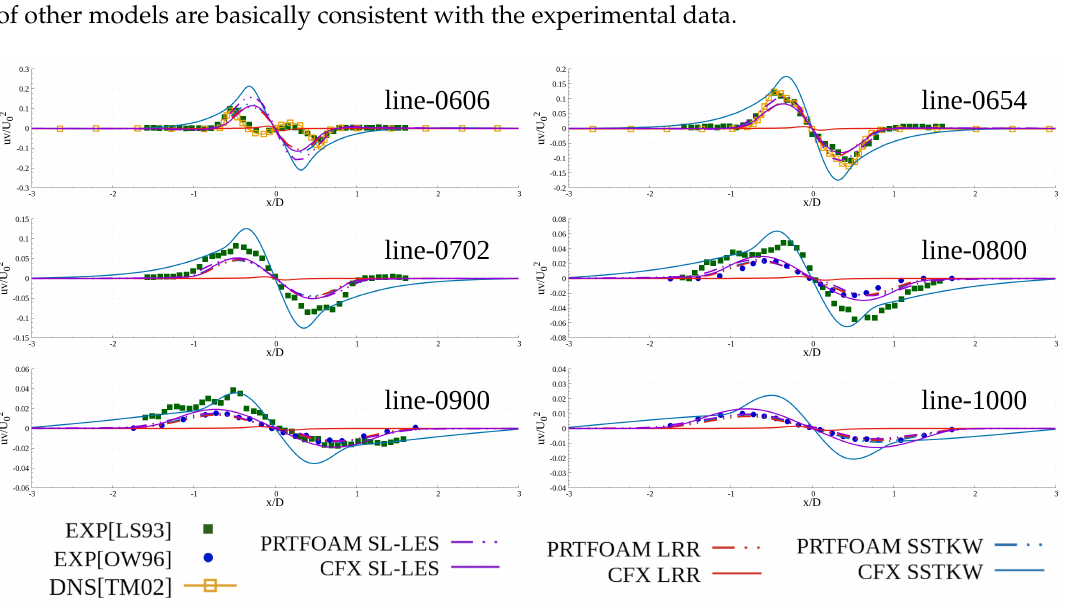
Figure 11. Comparison of mean Reynold shear stress at the vertical line behind the cylinder including our numerical simulation data, the DNS [34], and experimental data